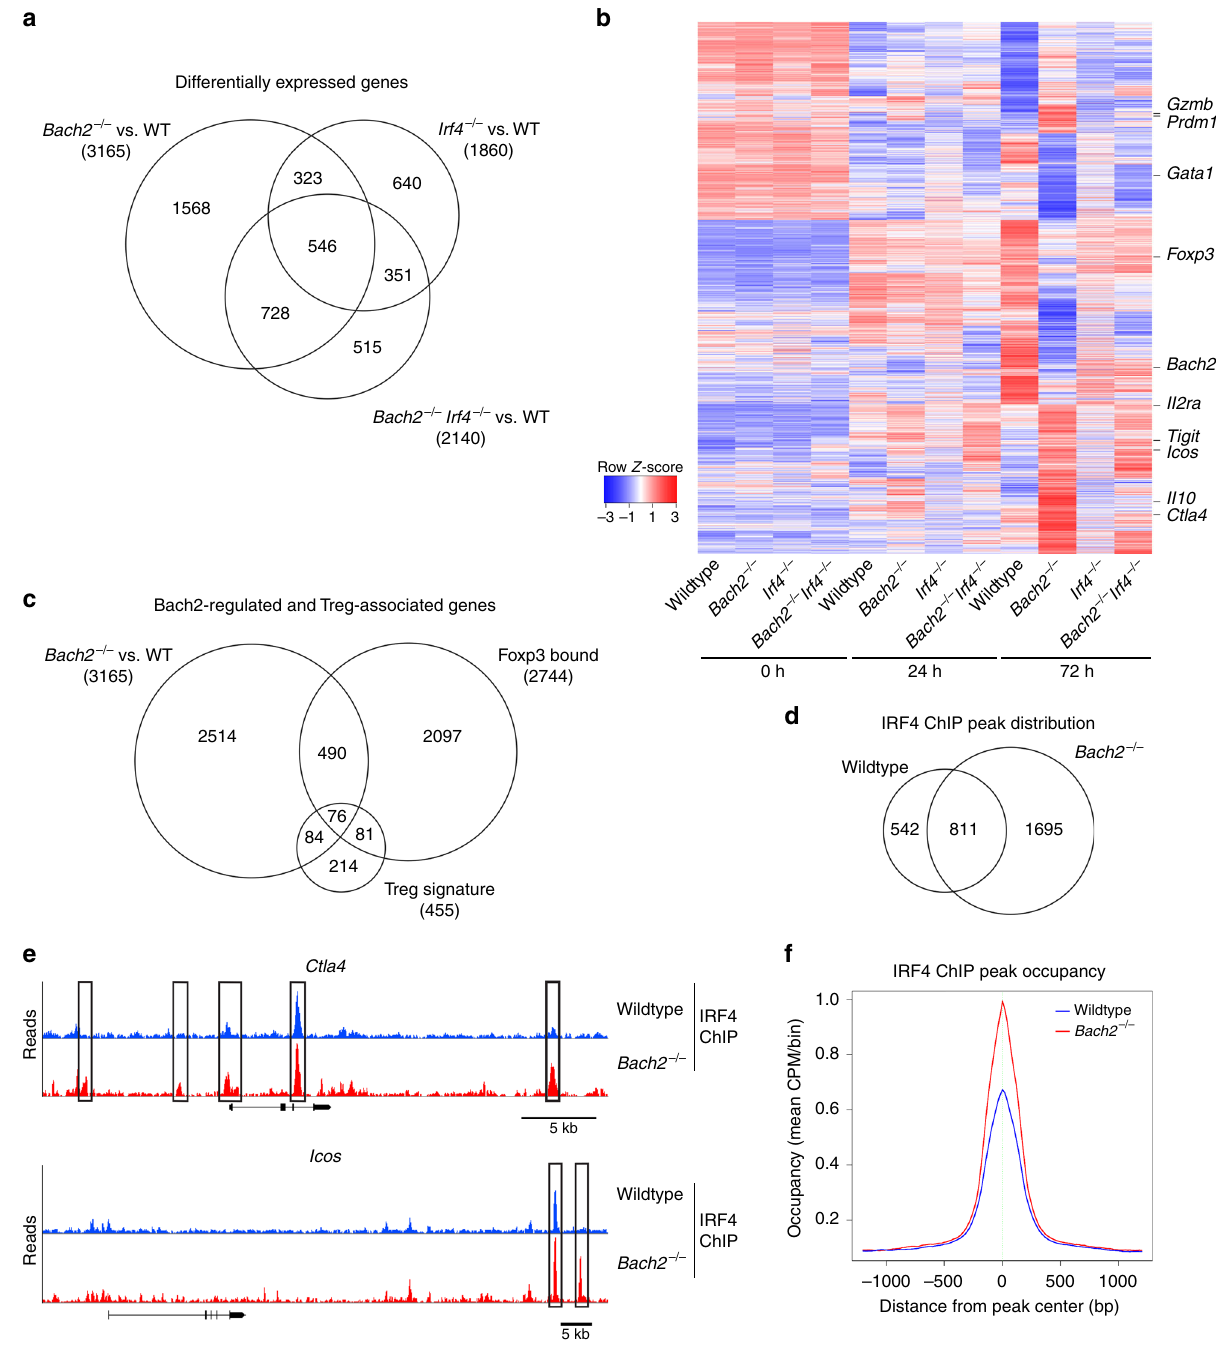
Fig. 7 IRF4-dependent transcriptional deregulation in the absence of Bach2. a – c Naive (CD62L + CD44 − CD25 − ) splenic CD4 T cells from wildtype, Bach2 − / − , Irf4 − / − and Bach2 − / − Irf4 − / − mice were cultured in Treg cell-inducing conditions for 0 h, 24 h, or 72 h and subjected to RNA-seq. Numbers of genes signi fi cantly differentially expressed between wildtype and each knockout genotype at 72 h ( a ). Heatmap showing expression ( Z -scores) of genes differentially expressed in Bach2 − / − compared to wildtype cells at each analysis time point ( b ). Overlap between genes differentially expressed in the 72 h Bach2 − / − vs. wildtype comparison, and those previously identi fi ed either as Foxp3-bound 11 or as Treg cell signature genes 42 ( c ). d – f ChIP-seq for IRF4 performed on naïve splenic CD4 T cells from wildtype and Bach2 − / − mice cultured in Treg cell-inducing conditions for 72 h. Numbers of peaks identi fi ed in each genotype ( d ), and example tracks showing loci with de novo or enhanced IRF4 binding in the absence of Bach2 ( e ). Mean occupancy of IRF4 at all called IRF4 ChIP peaks in wildtype and Bach2 − / − cells ( f ). Source data are provided as a Source Data fi